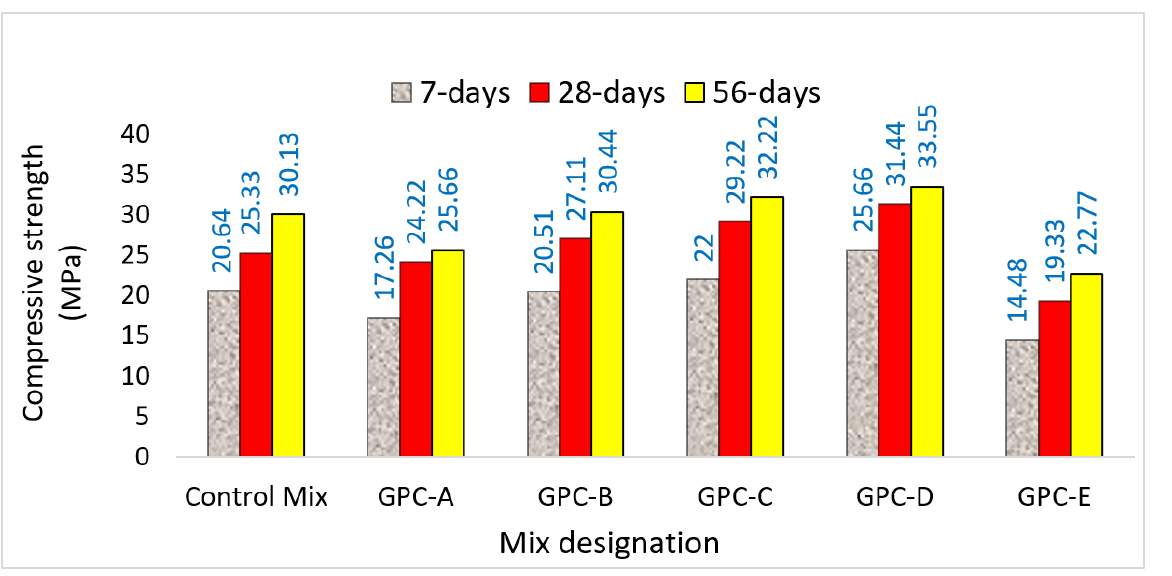
Figure 4. The compressive strength values of control (OPC) and QFS-GPC samples at 7, 28, and 56 days. The increase in the strength can be attributed to the content of calcium oxide [44].